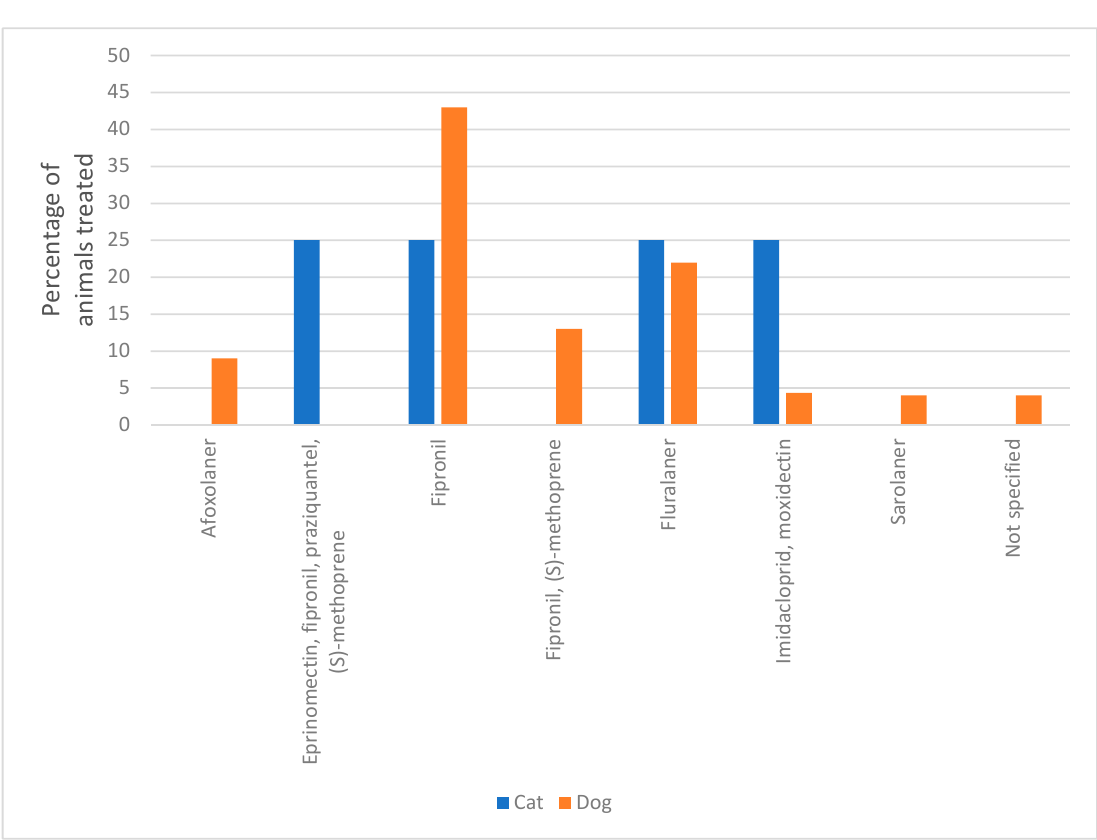
Figure 2. Active compounds of the ectoparasiticides used to treat dogs and cats in the survey.